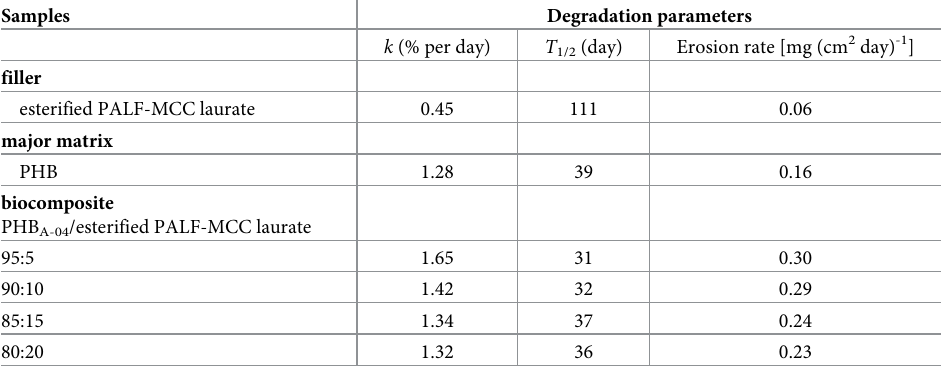
Table 3. The comparative data of degradation rates of PHB/esterified PALF-MCC laurate biocomposite films with esterified PALF-MCC laurate contents of 0, 5, 10, 15, 20 and 100% (w/w). Samples Degradation